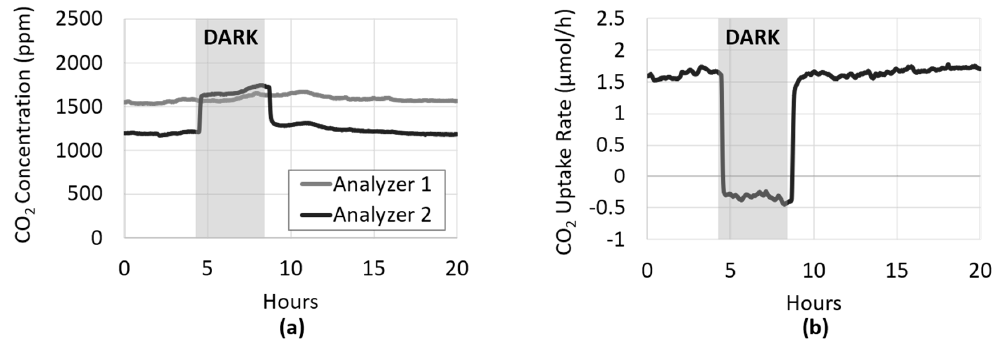
Figure 5. A steady state photoautotrophic biofilm was placed in the dark by covering BR cons with an opaque sheet for approximately 4 h. Time zero refers to twenty hours post inoculation. ( a ) Within minutes, the CO 2 concentration in the BR cons gas effluent (Analyzer 2) increased rapidly and remained elevated for the duration of the dark period. After illumination resumed, the effluent concentration quickly returned to its pre-dark level. ( b ) When converted and plotted as the rate of CO 2 uptake, the plot depicts a complete cessation of photosynthesis and CO 2 fixation in the dark, demonstrating the presence and activity of the photoautotrophic biofilm in BR cons .